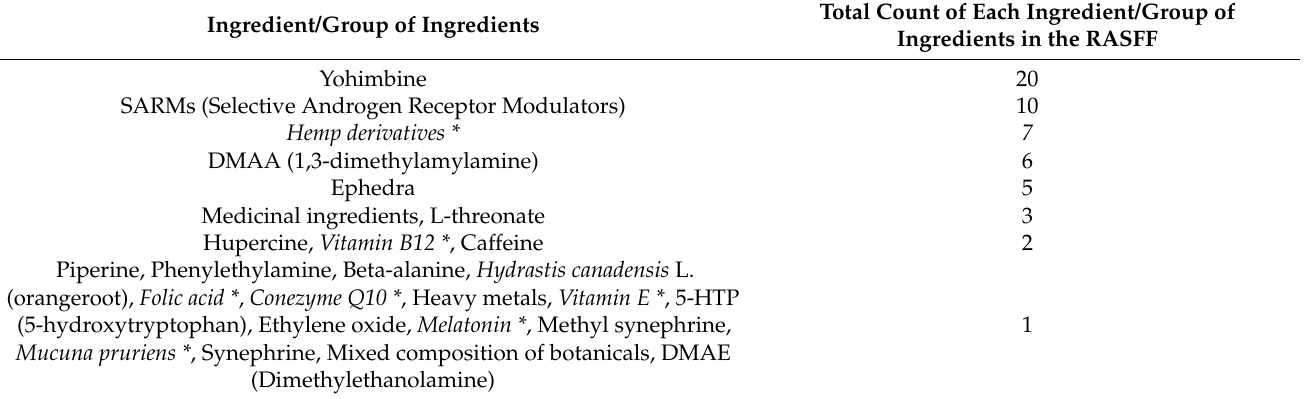
Table 2. List of ingredients/group of ingredients constituting the basis to enter a product into the RASFF in the group of “dietetical food ( . . .